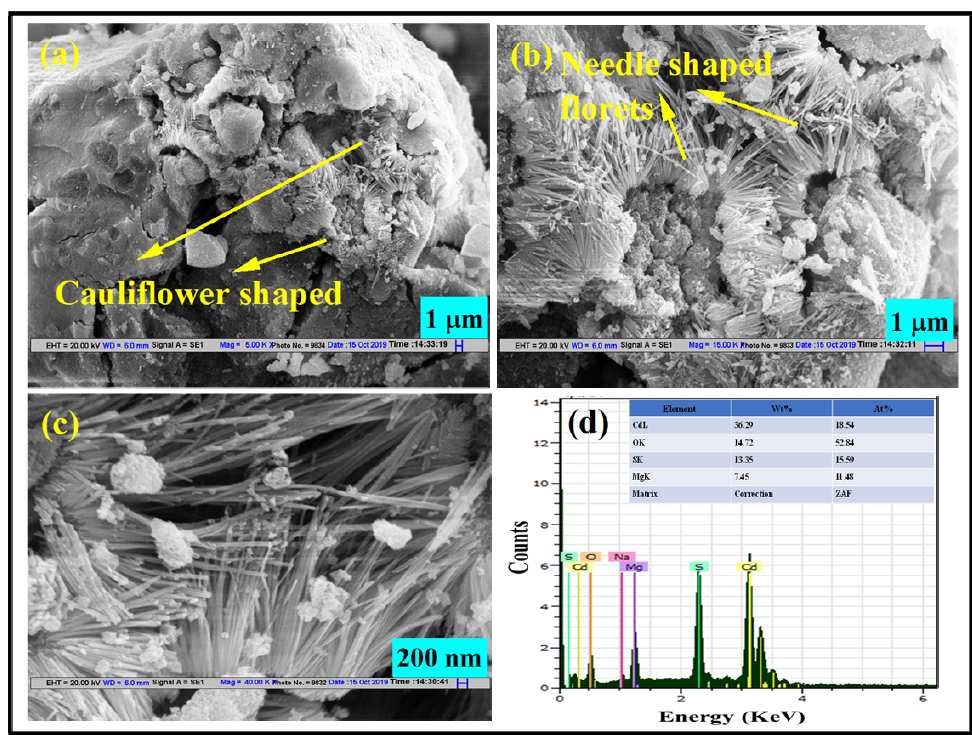
Fig. 2. (a)-(c) Showing Scanning electron microscopy of Mg(OH)